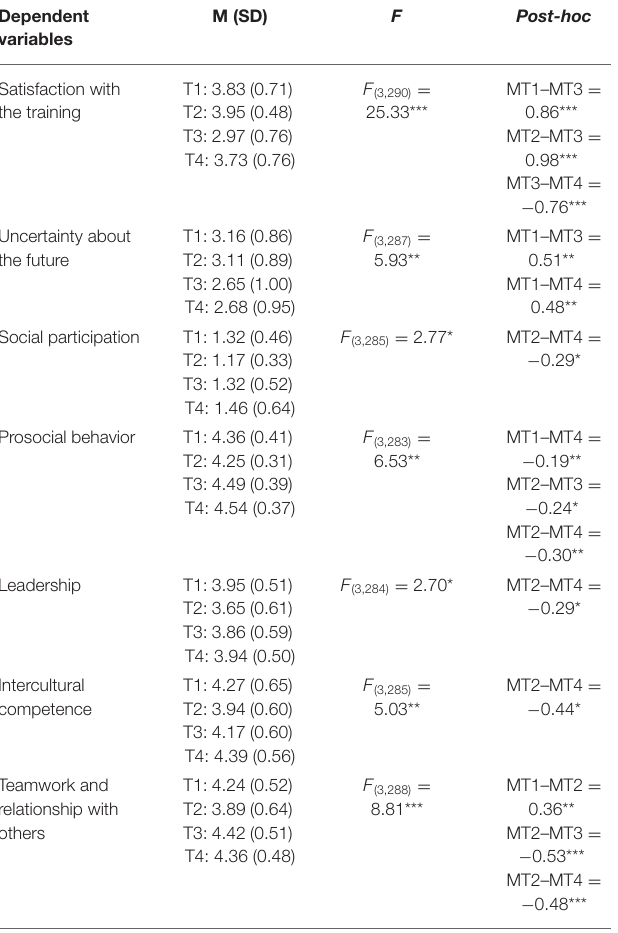
TABLE 3 | One-way ANOVA of the learning variables according to the time for reflection. Dependent